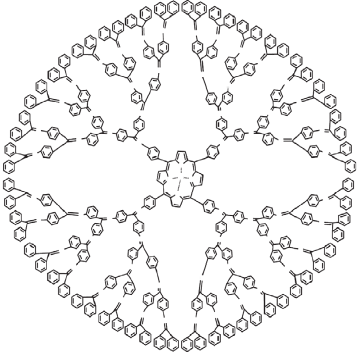
Figure 34: Zinc-porphyrin dendrimer DPZ Table 9: Degree-based edge partition of DPZ